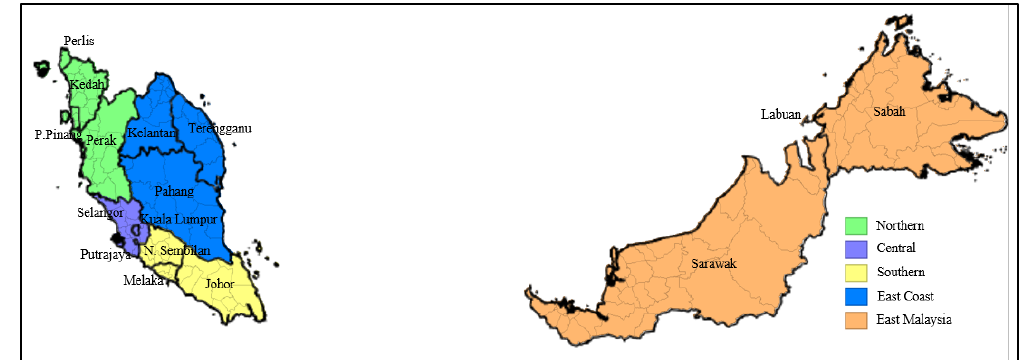
Figure 1. Baseline map of Malaysia. Dark boundaries depict states; light boundaries depict districts within states; color- shaded areas depict regions in Malaysia.